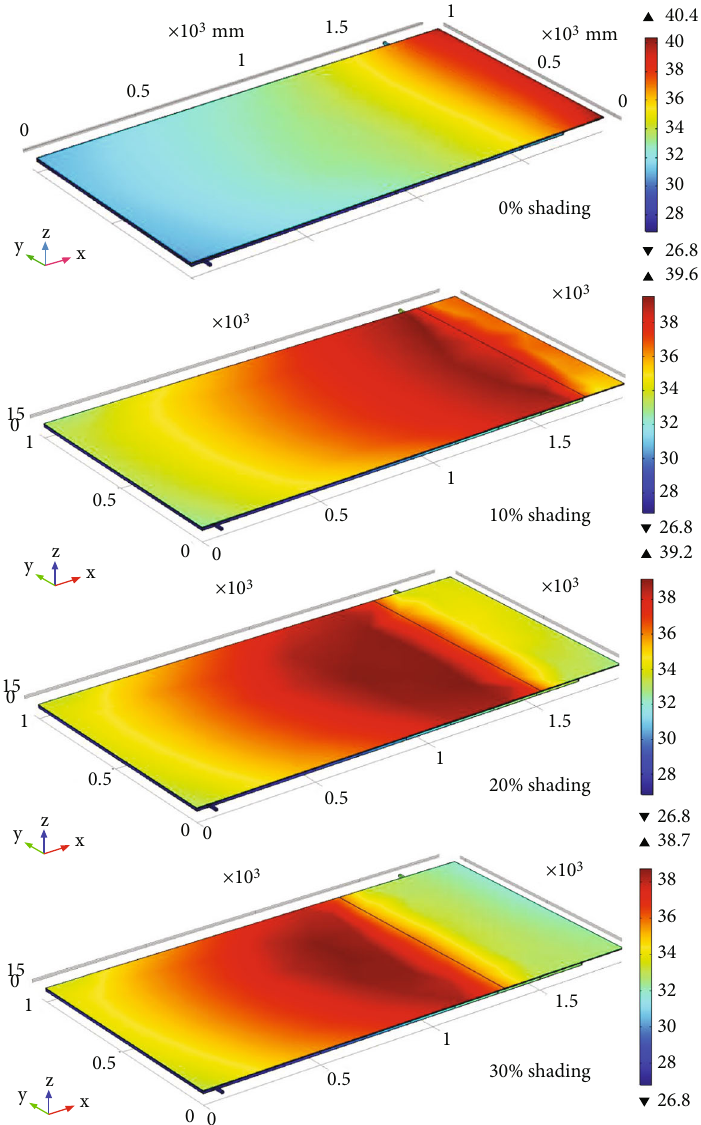
Figure 10: Outcome of partial shading on PVT surface temperature with G = 500 W/m 2 , V